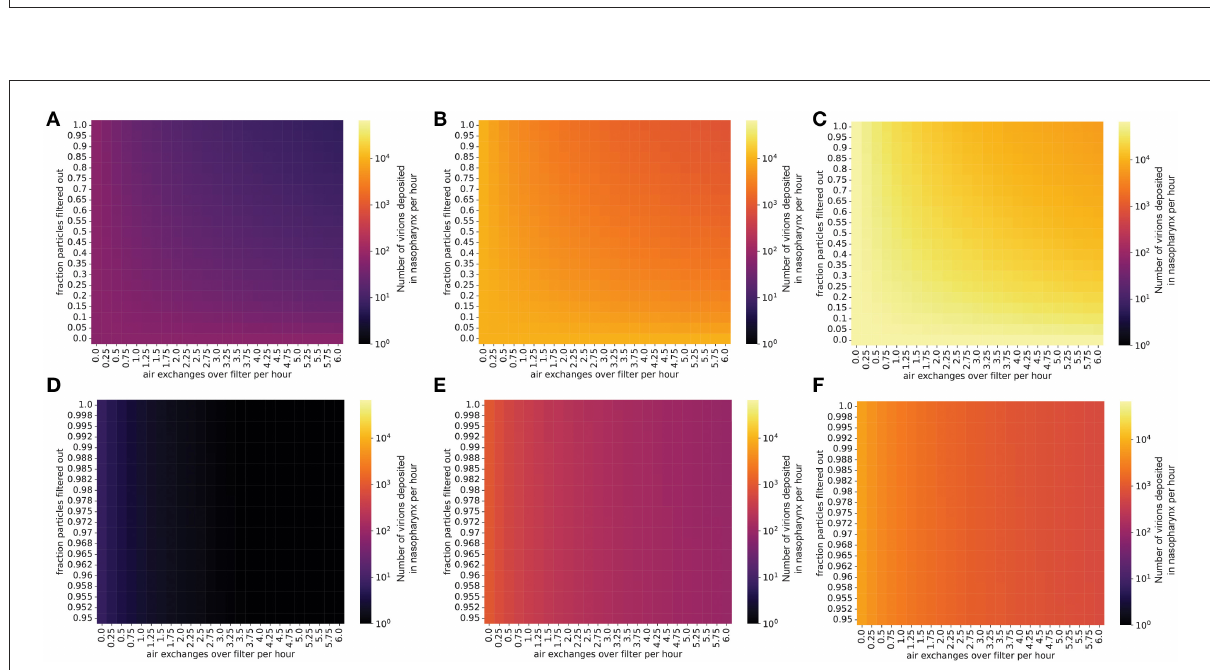
FIGURE4 Even with masks and air filtration, a person exposed to a high viral load emitter will be exposed to thousands of virions per day. Virions inhaled by an uninfected individual per hour in the presence of an infected individual, in a room with the same dimensions as Figure 1. The probability that an inhaled virion hits nasopharynx was estimated at 0.6% (methods). (A–C) Individual infected with a low viral load, (A) intermediate viral load, (B) or high viral load, (C) strain, no mask. (D–F) Individual infected with a low viral load (D) , intermediate viral load (E) , or high viral load (F) strain, with the emitter wearing a 90% effective mask (one-way